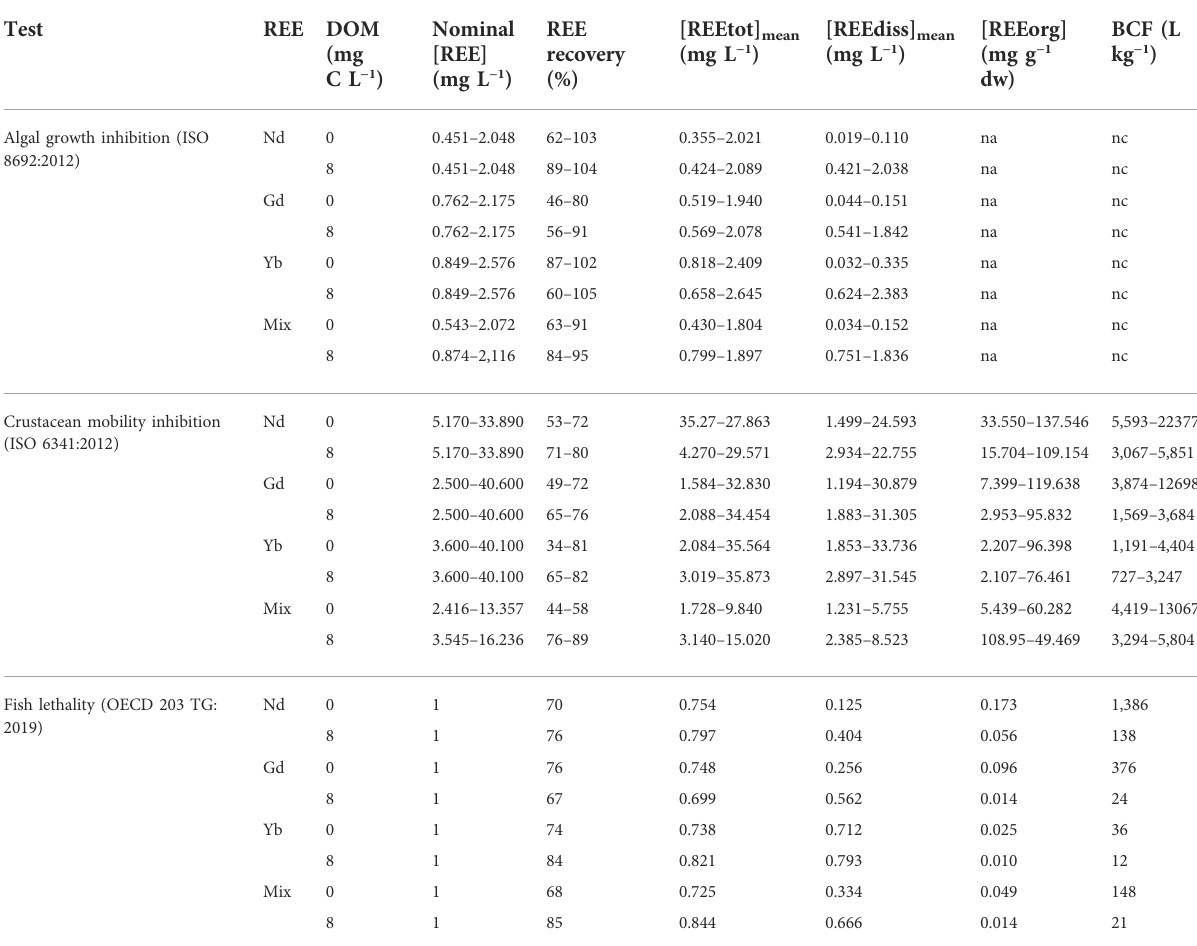
TABLE 1 REE concentrations in the medium and the organisms. Data represent the interval (min-max) of fi ve values each. REE recovery at t1 was calculated as the ratio between the total REE mass (sum of REE mass in the water and the organisms) measured at t1 and the nominal total REE mass introducedat t0. [REEtot] mean and[REEdiss] mean correspond to the geometric mean (= √ (C0*C1)) where C0 refers tothe nominalconcentration att0and C1referstothetotalor dissolvedconcentrationmeasuredatt1.[REEorg] corresponds tothe meanofREE concentrationsmeasuredatt1in 8 fi shes (in fi sh test) or to the REE concentration measured at t1 in a pool of daphnids ( ≥ 20 daphnids) (in crustacean test). dw = dry weight. BCF = Bioconcentration factor = [REEorg]/[REEdiss] mean . na = non available. nc = not